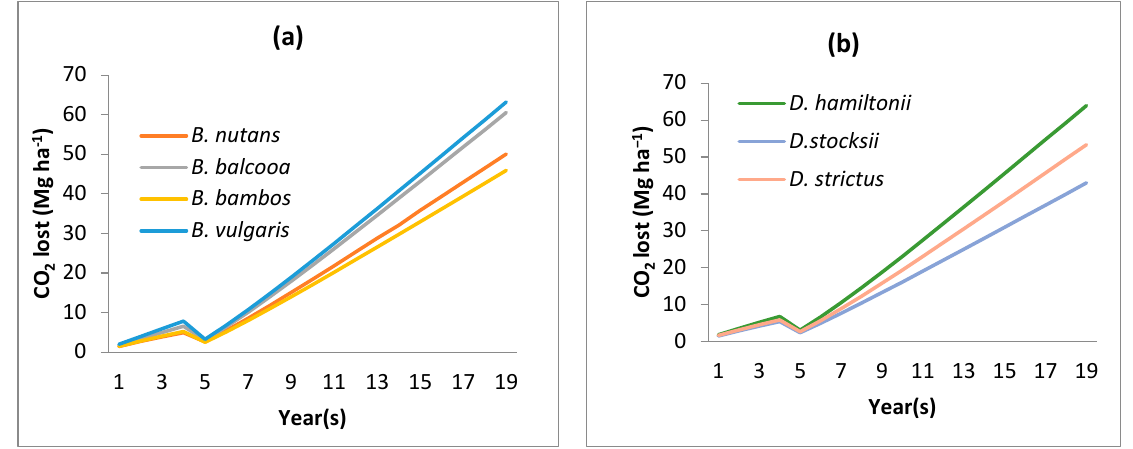
Figure 3. CO 2 evolution under a usual scenario in ( a ) Bambusa species and ( b ) Dendrocalamus species. Table 2. Statistics describing performance of model for each treatment.